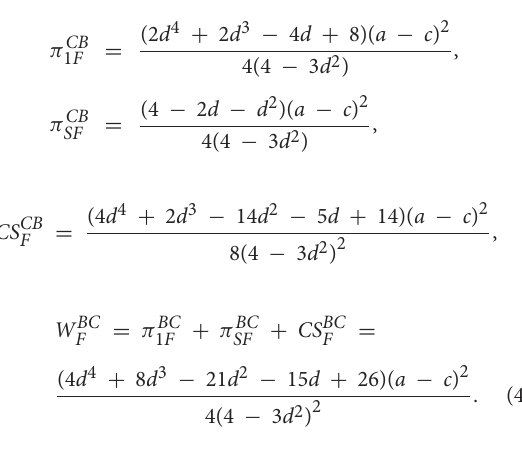
The price and quantity levels are as in (19) with r =